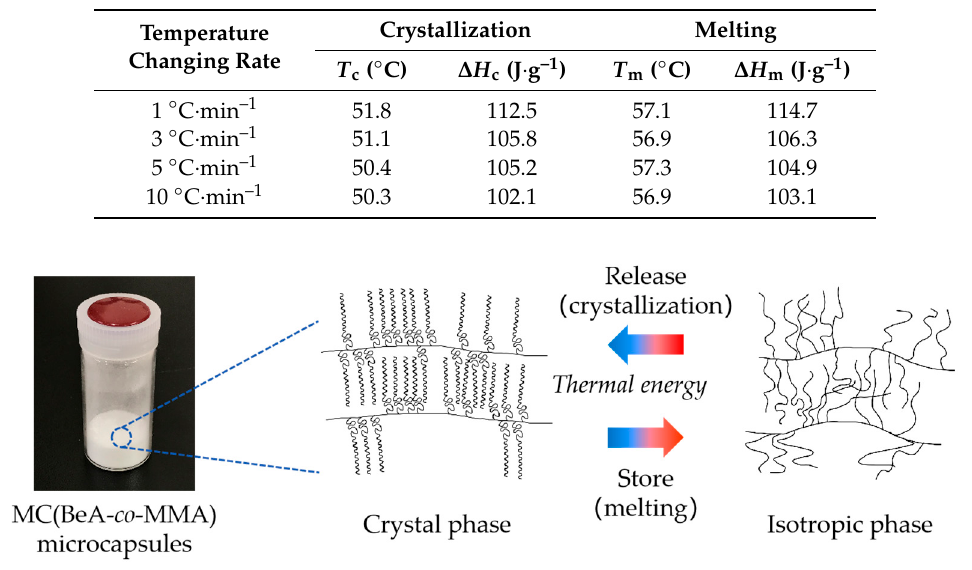
Figure 6. Schematic diagram of the phase transition behavior and crystal structure of MC(BeA- co -MMA) microcapsules with a crystalline n -behenyl side-chain.